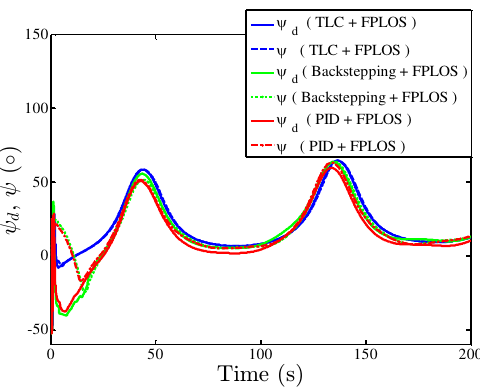
Figure 12. Control inputs µ .